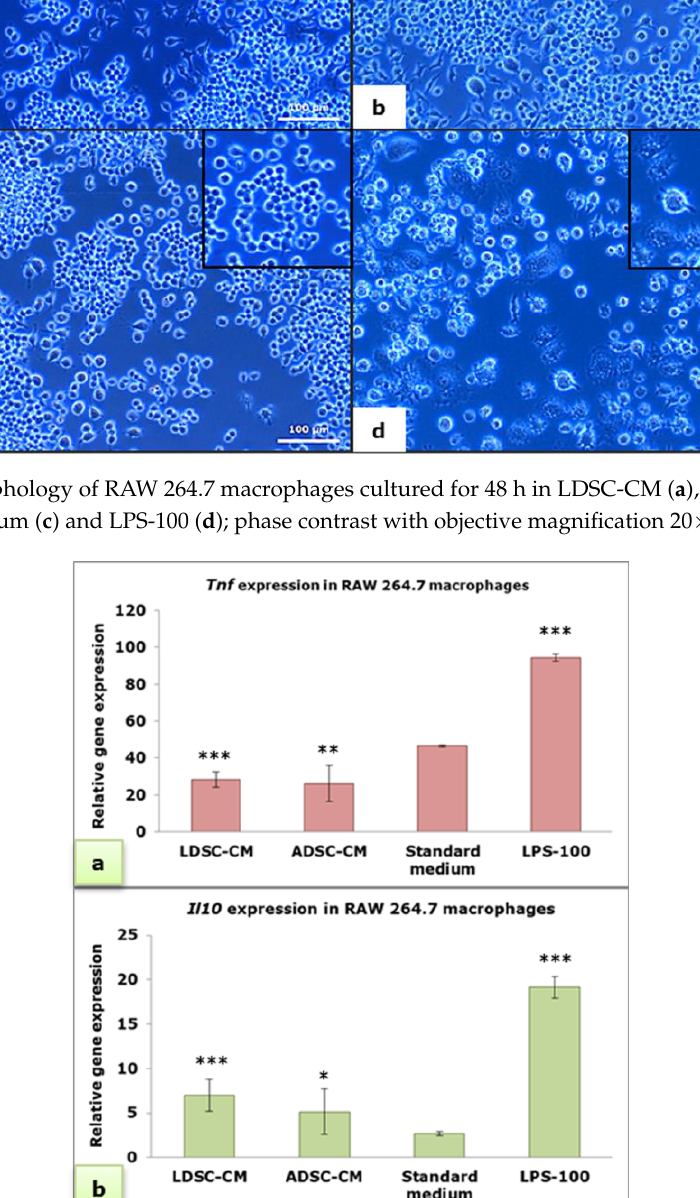
Figure 5. Relative expression of Tnf ( a ) and Il10 ( b ) genes in RAW 264.7 macrophages cultured for 48 h in LDSC-CM, ADSC-CM, standard medium and LPS-100, normalized to Actb ; mean ± standard deviation (SD); n(LDSCs) = 4 and n(ADSCs) = 4 (n − number of patients per group); for each patient sample culture-derived CM, as well as controls, four replicates were analyzed; (*) p < 0.05, (**) p < 0.01, (***) p < 0.001 (compared to standard